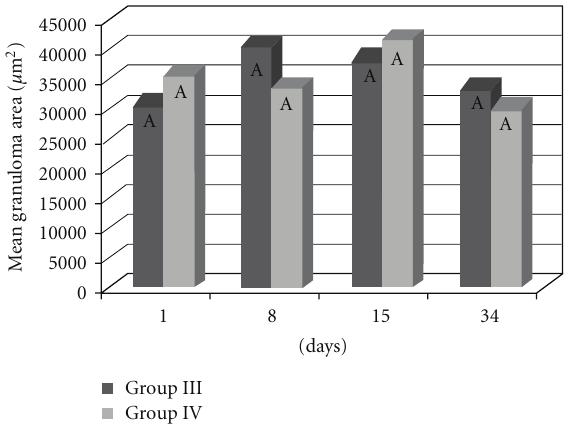
Figure 8: The granulomatous area in the liver of the mice that were previously infected with the S. mansoni BH strain and then inoculated 8 weeks later with eggs from the S. mansoni BH (Group III) or SJ (Group IV) strains. The mice were euthanized 1, 8, 15, or 34 days after inoculation with the eggs. At each time point, the means depicted with the same letter do not di ff er significantly ( α = 0 .